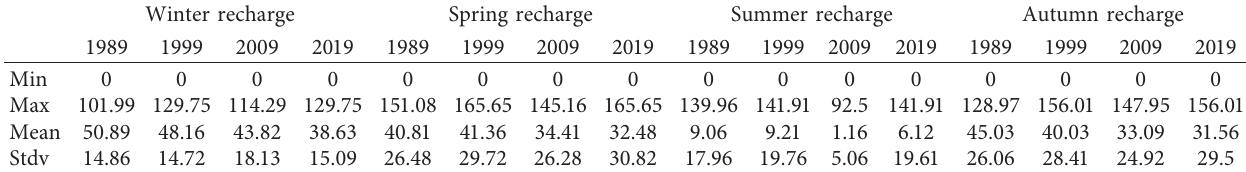
Table 12: Long-term seasonal WetSpass-M simulated groundwater recharge (mm) of the Bilate basin for a LULC (1989, 1999, 2009, and 2019).